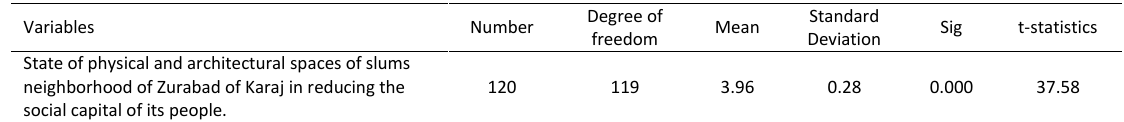
Table 3: Results of test for the current state of physical and architectural spaces of the slums neighborhood of Zurabad of Karaj in reducing the social capital of people of the neighborhood. Degree of Standard Variables Number Mean Sig t-statistics freedom Deviation